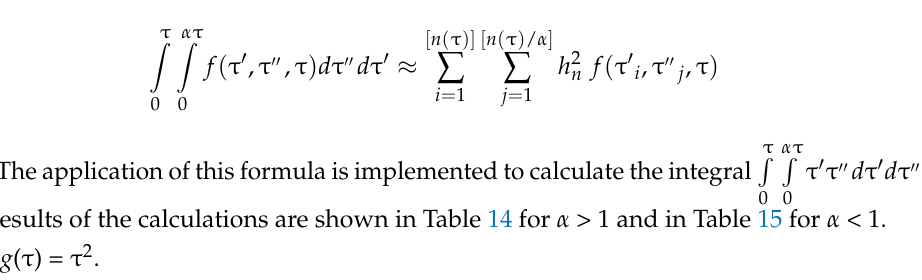
g ( τ ) = ατ , α < 1. τ=τ for 3